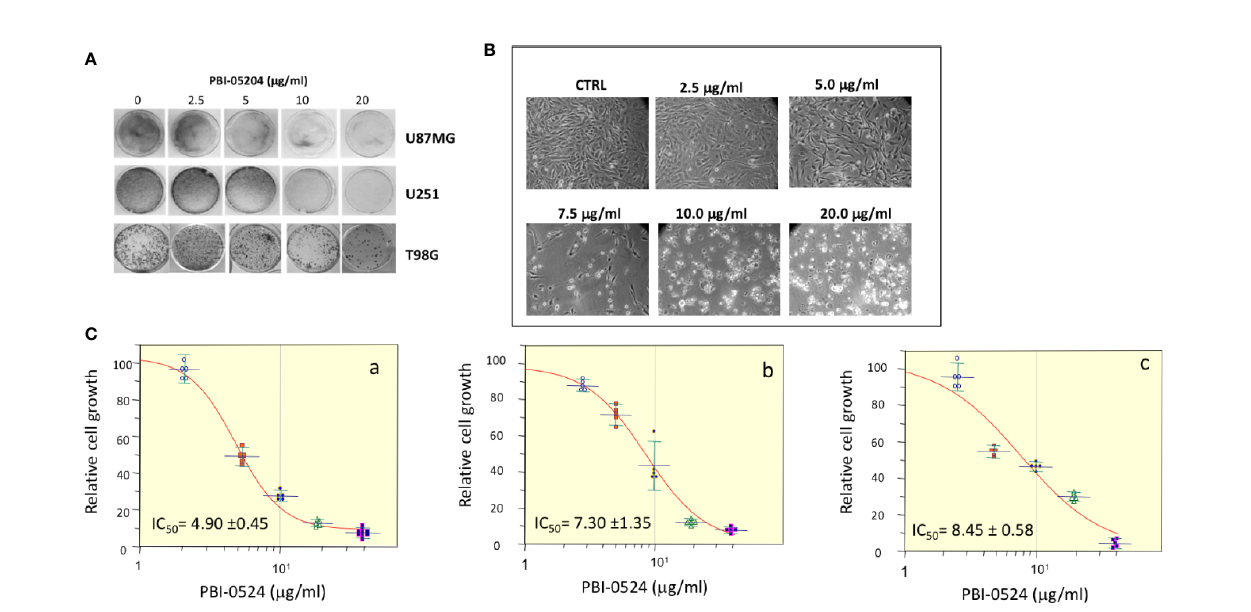
FIGURE 1 | Antiproliferative effects of PBI-05204 on established glioblastoma (GBM) cell lines. (A) crystal violet assay showing the growth inhibition of cells evidenced by the changes in staining of U87MG, U251, and T98G cell lines. (B) Morphological changes of U87MG cells treated with different doses of PBI-05204. (C) The growth curve of human GBM cells, U87MG (a), U251 (b), and TG98 (c) treated with PBI-05204 for 72 h. Data are presented as mean ±